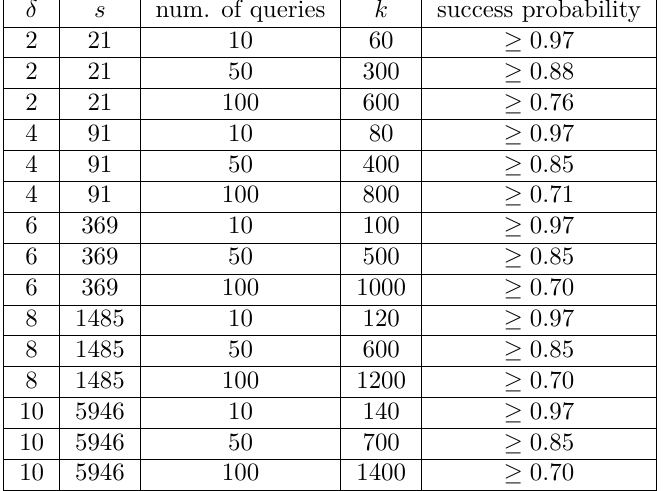
Table 5.1: This table presents an approximated lower bound on the probability to recover k bits of key material with the subversion attack e E δ,s , under the assumption that the adversary does at least the specified number of